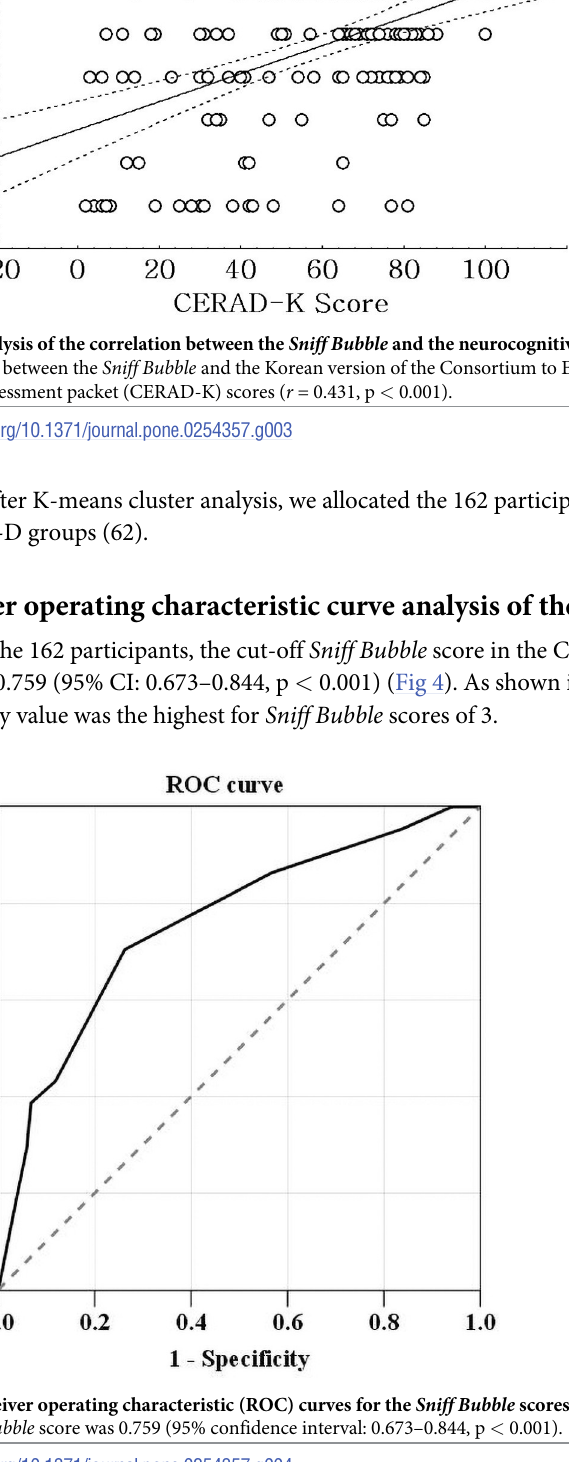
Fig 4. Receiver operating characteristic (ROC) curves for the Sniff Bubble scores. Area under the curve (AUC) for the Sniff Bubble score was 0.759 (95% confidence interval: 0.673–0.844, p < 0.001).